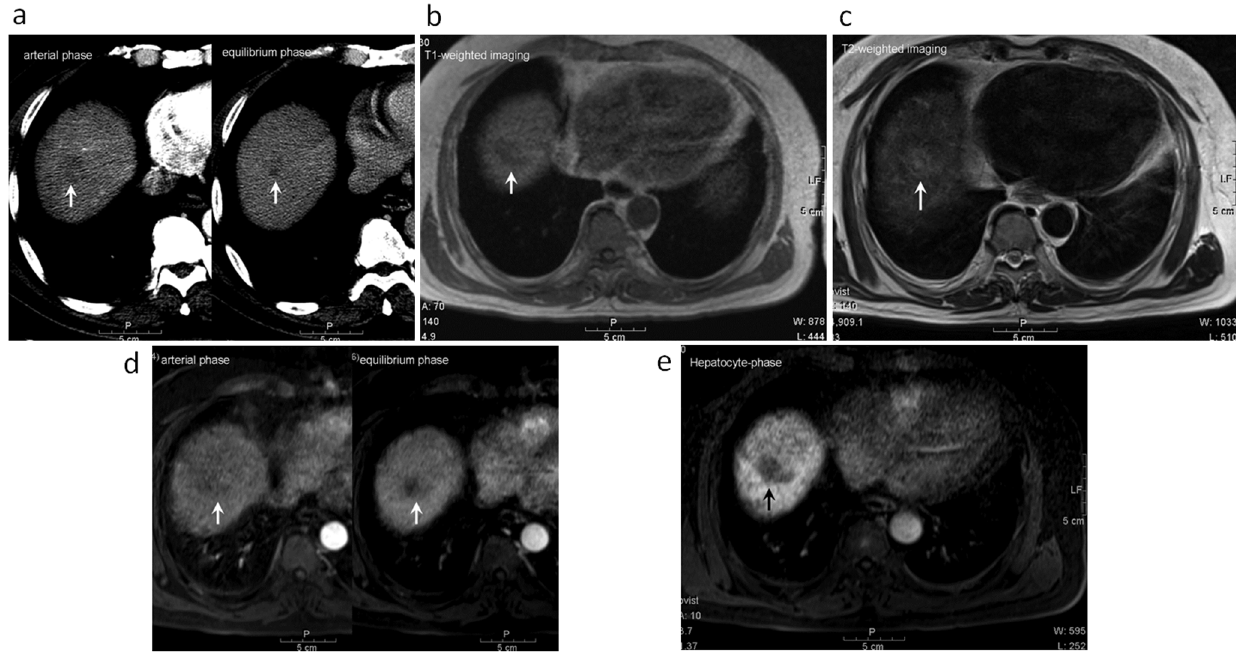
Figure 2. A 57-year-old male with a well-differentiated hepatocellular carcinoma (indicated by arrow) at S8 of the liver underwent gadoxetic acid-enhanced MR imaging and liver biopsy. (a) The tumor depicted hypovascular enhancement in the arterial-phase image and isodensity to hypodensity relative to the adjacent liver parenchyma on equilibrium-phase dynamic CT study. (b) The tumor showed hypointensity on the T1-weighted image. (c) The tumor showed isointensity to hyperintensity on T2-weighted image. (d) The tumor also showed hypovascular enhancement in arterial-phase imaging and hypointensity relative to the adjacent liver parenchyma on equilibrium phases of dynamic MR study. (e) The tumor showed hypointensity on the gadoxetic acid-enhanced hepatocyte-phase T1-weighted